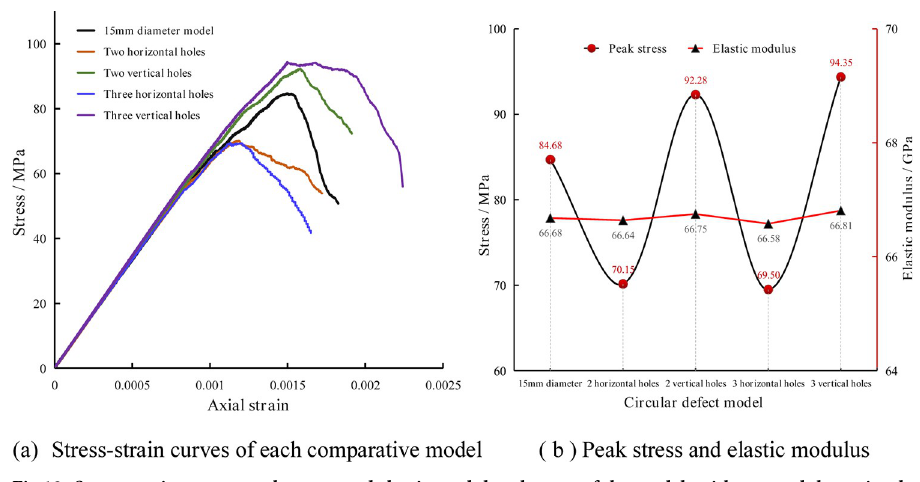
Fig 12. Stress-strain curves, peak stress, and elastic modulus changes of the models with two and three circular holes. (a) Stress-strain curves of each comparative model, (b) Peak stress and elastic